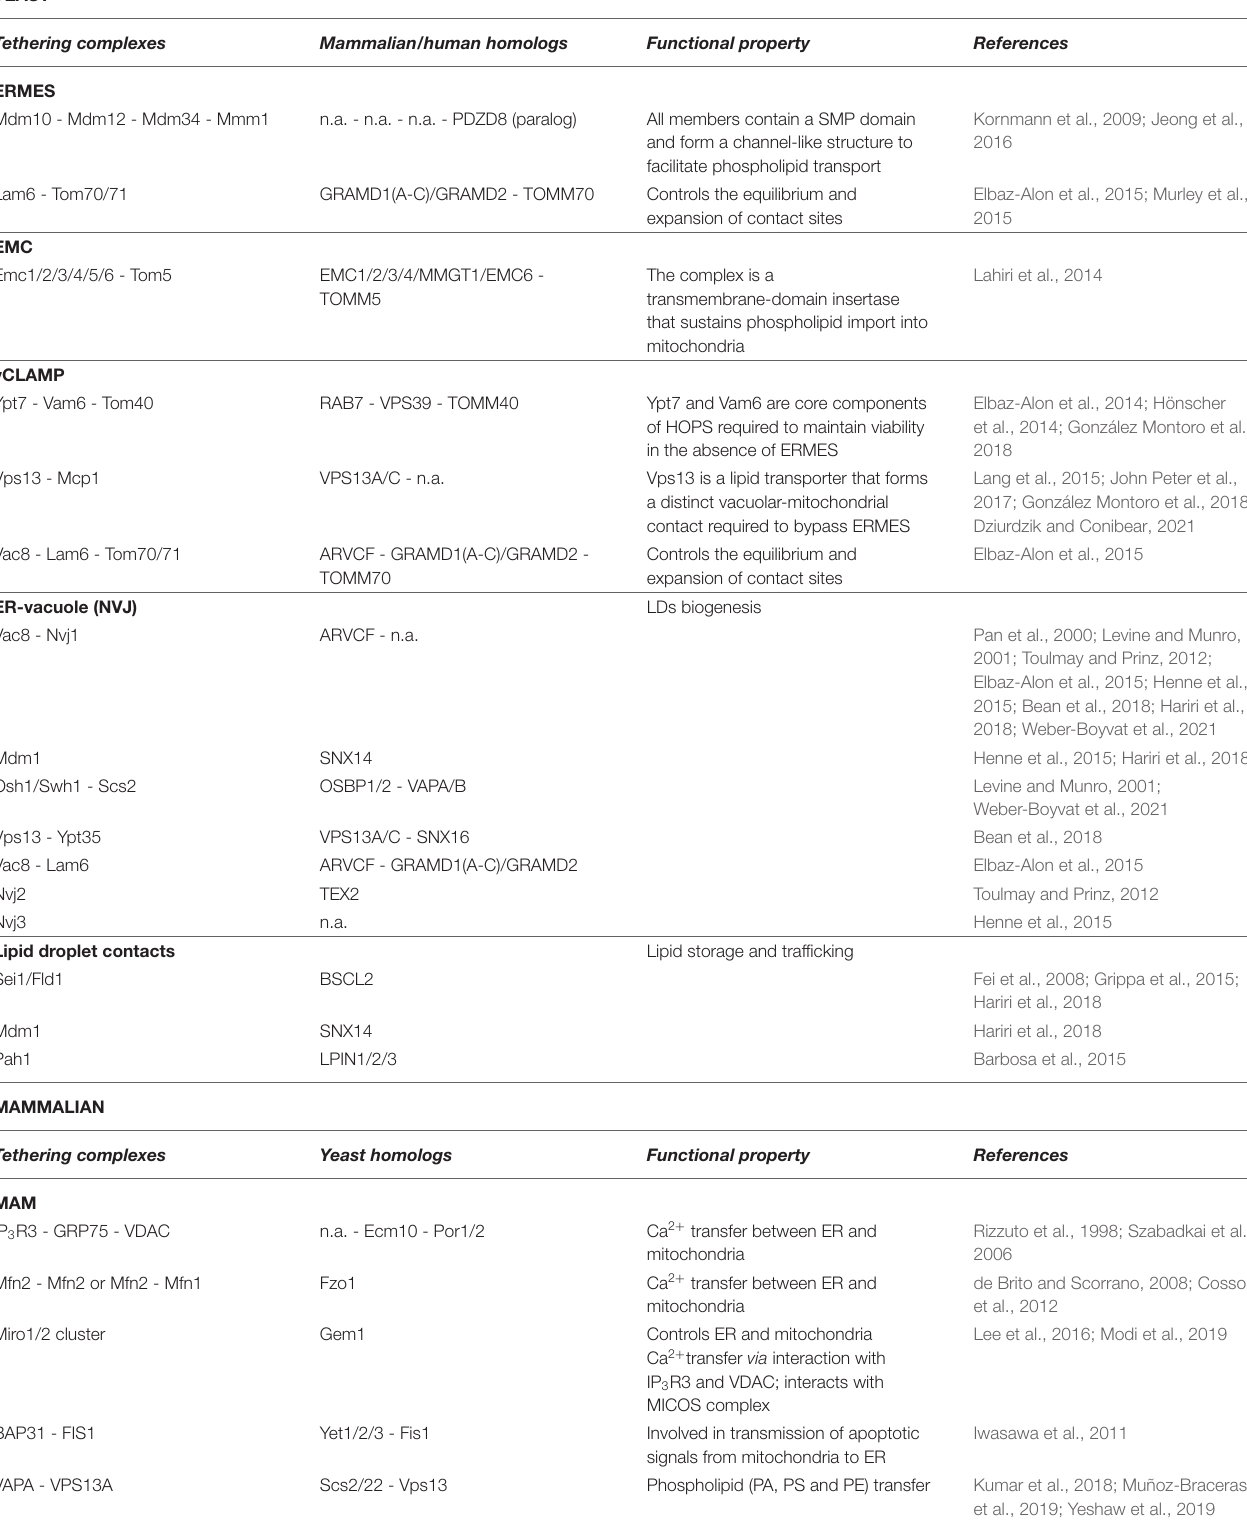
TABLE 1 | Molecular determinants for inter-organellar tethering.